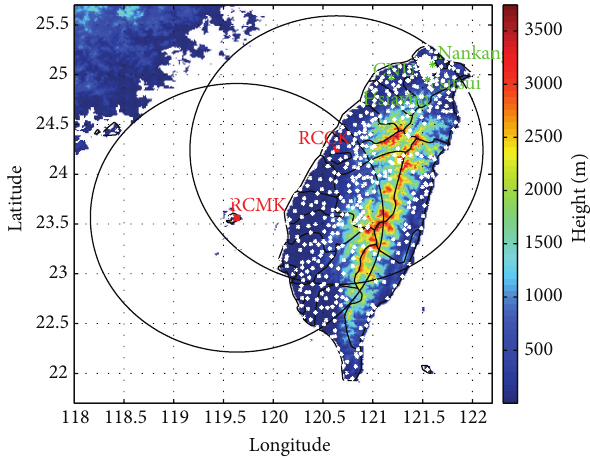
Figure 1: The locations of the C-band dual-polarization radars (marked with red squares), JWDs (marked with green stars), and the gauge network (marked with white stars) used in the current work. The black circles indicate the radar coverage ranges of 150 km.